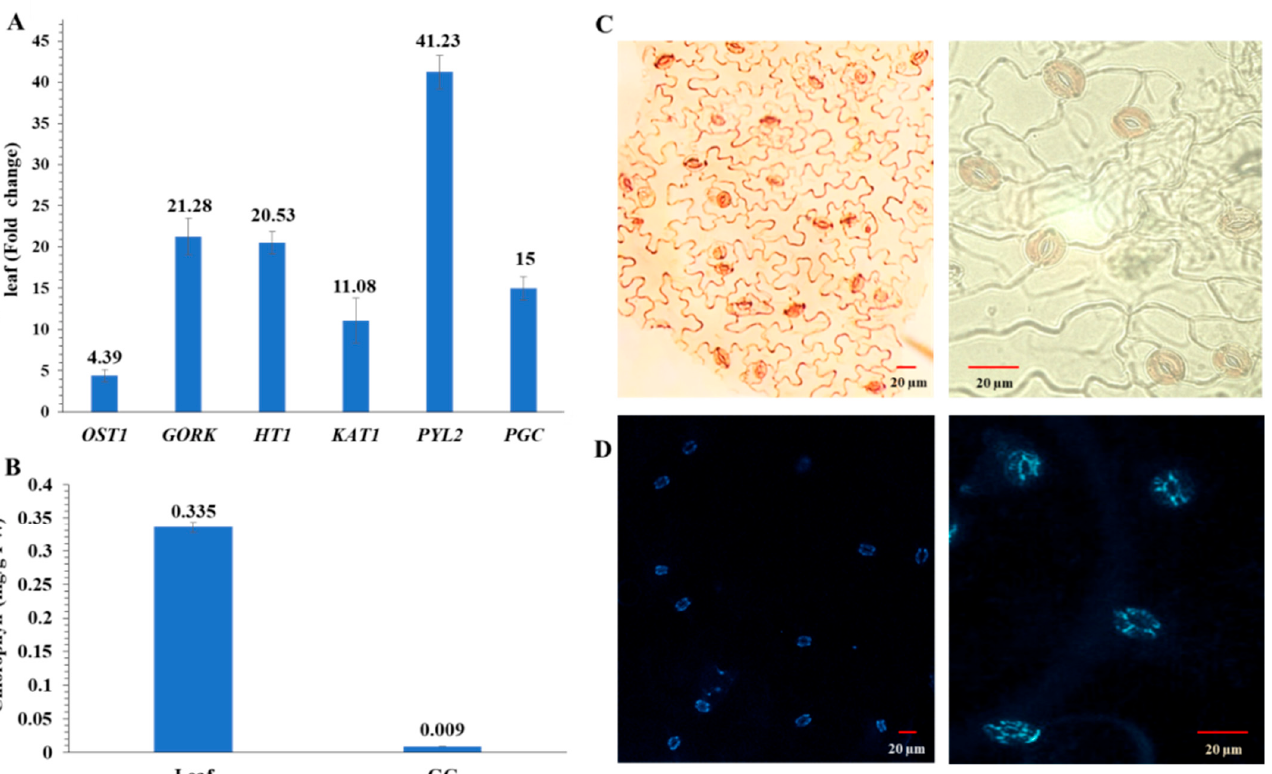
Figure 2. Enriched guard cell (GC) purity and viability assays. ( A ) Transcript abundances of six genes based on their fold differences in guard cell samples compared to leaf samples. Standard error of the mean was calculated from three biological replicates and three technical replicates. OST1, open stomata 1; GORK, guard cell outward-rectifying potassium channel; HT1, high temperature 1; KAT1, potassium channel; PYL2, pyrabactin resistance-like 2; and PGC, promoter guard cell 1 (At1g22690). ( B ) Chlorophyll contents in four replicates of leaves or enriched guard cells. The data are presented as average ± standard error. ( C ) Neutral red staining of the enriched guard cells. ( D ) Fluorescein diacetate (FDA) staining of the enriched guard cells isolated with a blender.